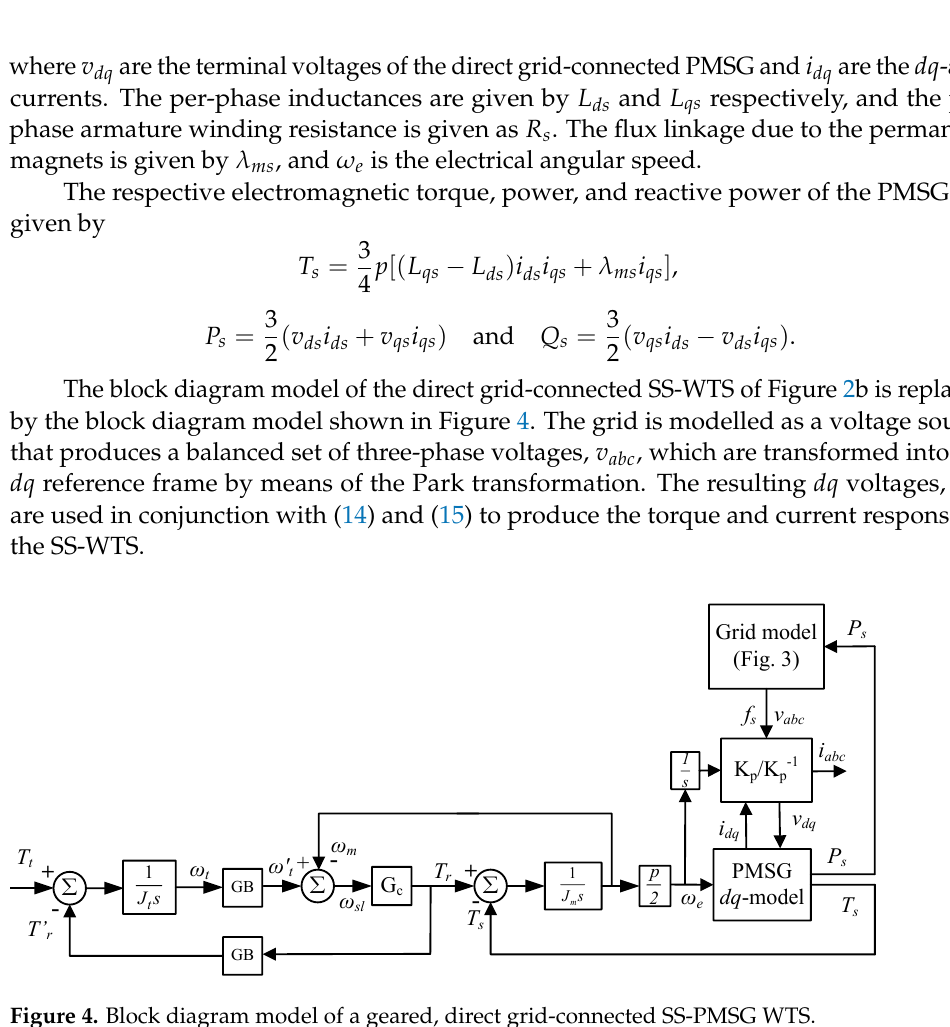
Figure 4. Block diagram model of a geared, direct grid-connected SS-PMSG